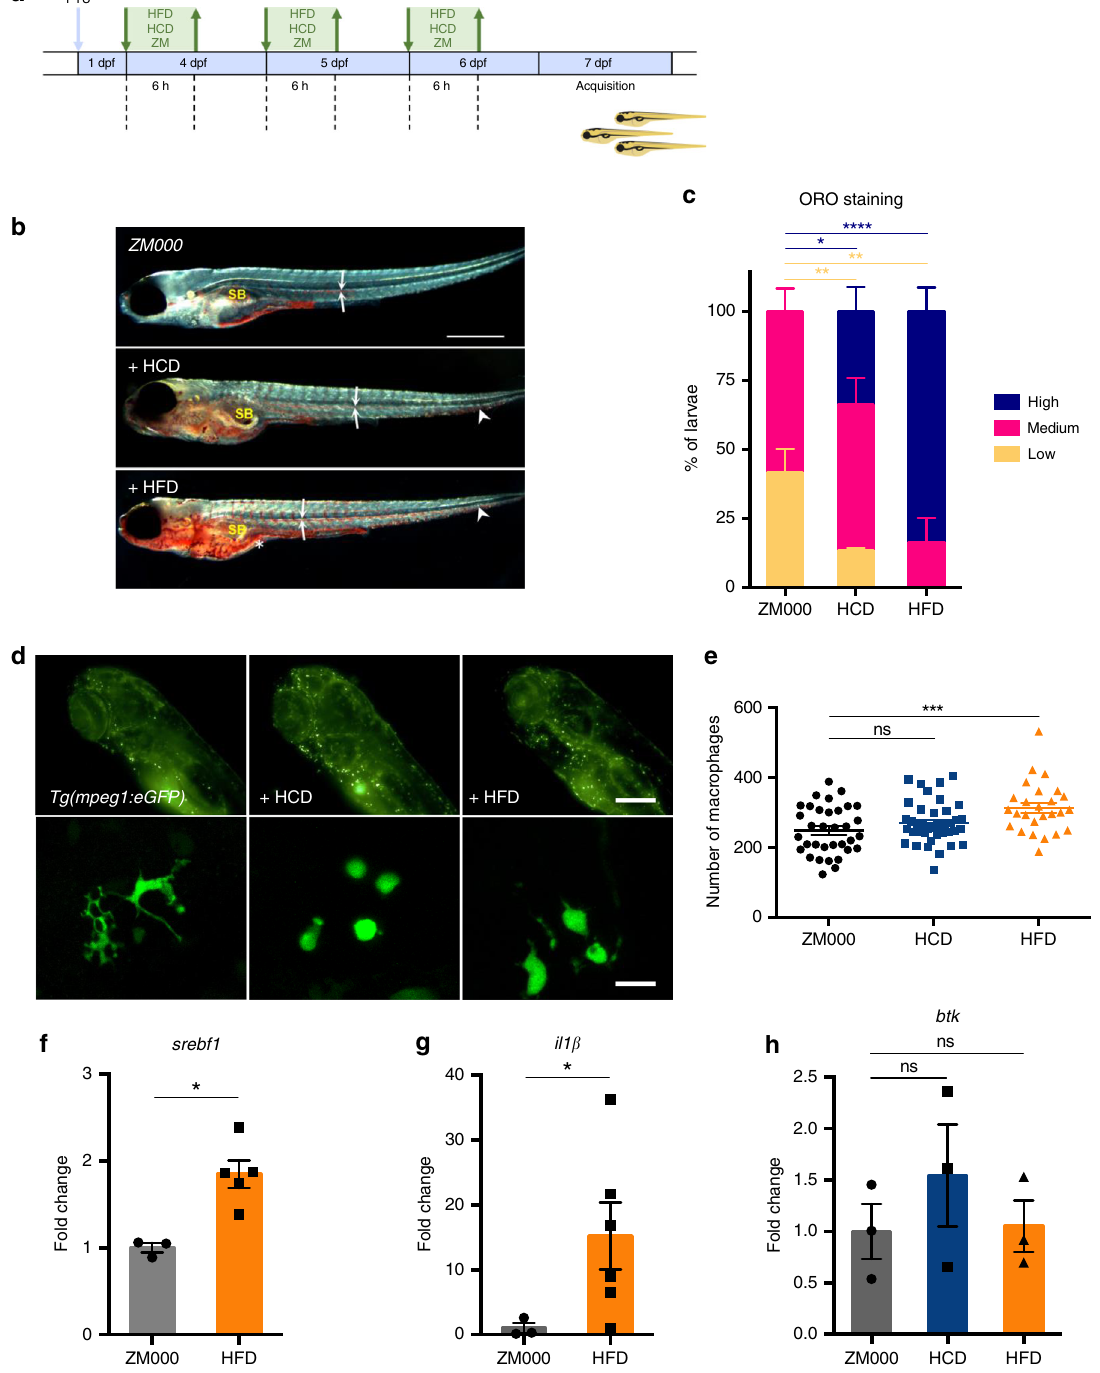
Fig. 8 High fat diet induces lipid and macrophage accumulation in zebra fi sh. a Schematic representation of the protocol used for the experiments. Zebra fi sh larvae were fed with high fat (HFD), high cholesterol (HCD) or standard (ZM) diet for 6h each day from day 4 to day 6 post fertilization (dpf). PTU: 1-phenyl 2-thiourea. b 7 dpf Casper zebra fi sh larvae, fi xed and stained with Oil Red O: representative low (i), medium (ii), and high (iii) staining levels un larvae fed with the indicated diet are shown. SB: swim bladder. Arrows point to lipids in blood vessels; arrowheads point to lipid droplets in the tail region; asterisks indicate the intestine. Dark- fi eld images, calibration bar: 500 μ m. c Percentage of larvae with high, medium and low lipid accumulation for the three indicated diets. Data are pooled from two experiments ( n >12) and the charts show the mean ±SEM. Blue asterisks refer to statistics of low stained larvae, red asterisks refer to statistics of high stained larvae. **** p -value<0.0001, ** p -value< 0.01, * p -value<0.05 (two-way ANOVA test). d Representative fl uorescent images of the head + yolk regions of larvae obtained using the Operetta system (i – iii — calibration bar: 100 μ m) and the confocal microscope (i ′ – iii ″ — calibration bar: 20 μ m). e Quanti fi cation of macrophages for the three considered diets. f – h Quantitative PCR analysis of the expression of sterol regulatory element binding transcription factor 1 ( srebf1 ), interleukin-1 beta ( il1 β ) and bruton tyrosine kinase ( btk ) in larvae fed and treated as indicated. In e data are pooled from three or more experiments ( n > = 26) and ** p -value< 0.01, * p -value< 0.05 (Mann – Whitney test). Source data are provided as a Source Data fi